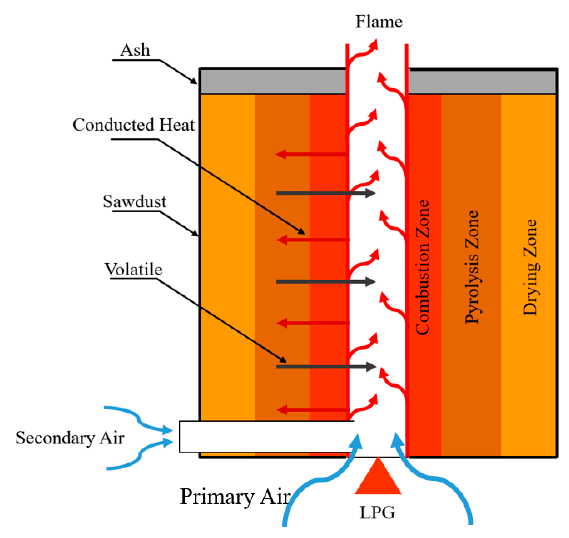
Figure 6. Sawdust layer in stove.